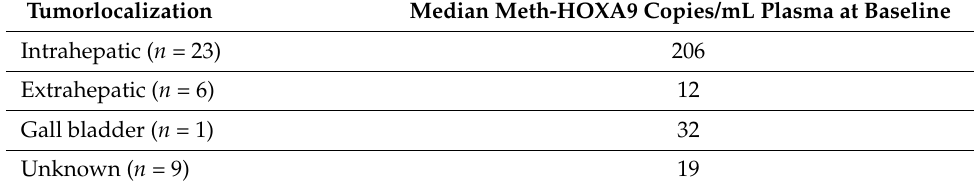
Table 2. Tumorlocalization and